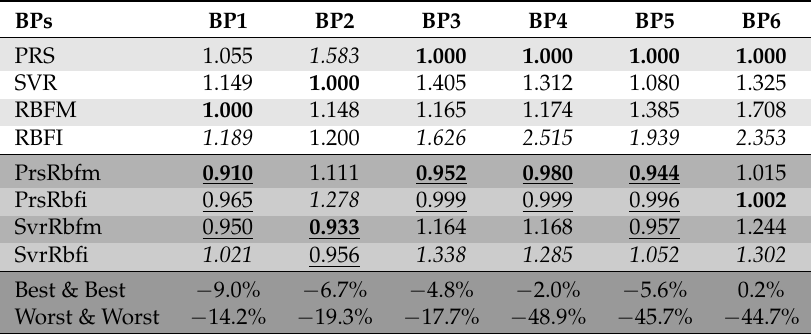
Table 5. Normalized means of MAE of the metamodels for each benchmark problem with 3 ( k + 1 )( k + 2 ) training points.